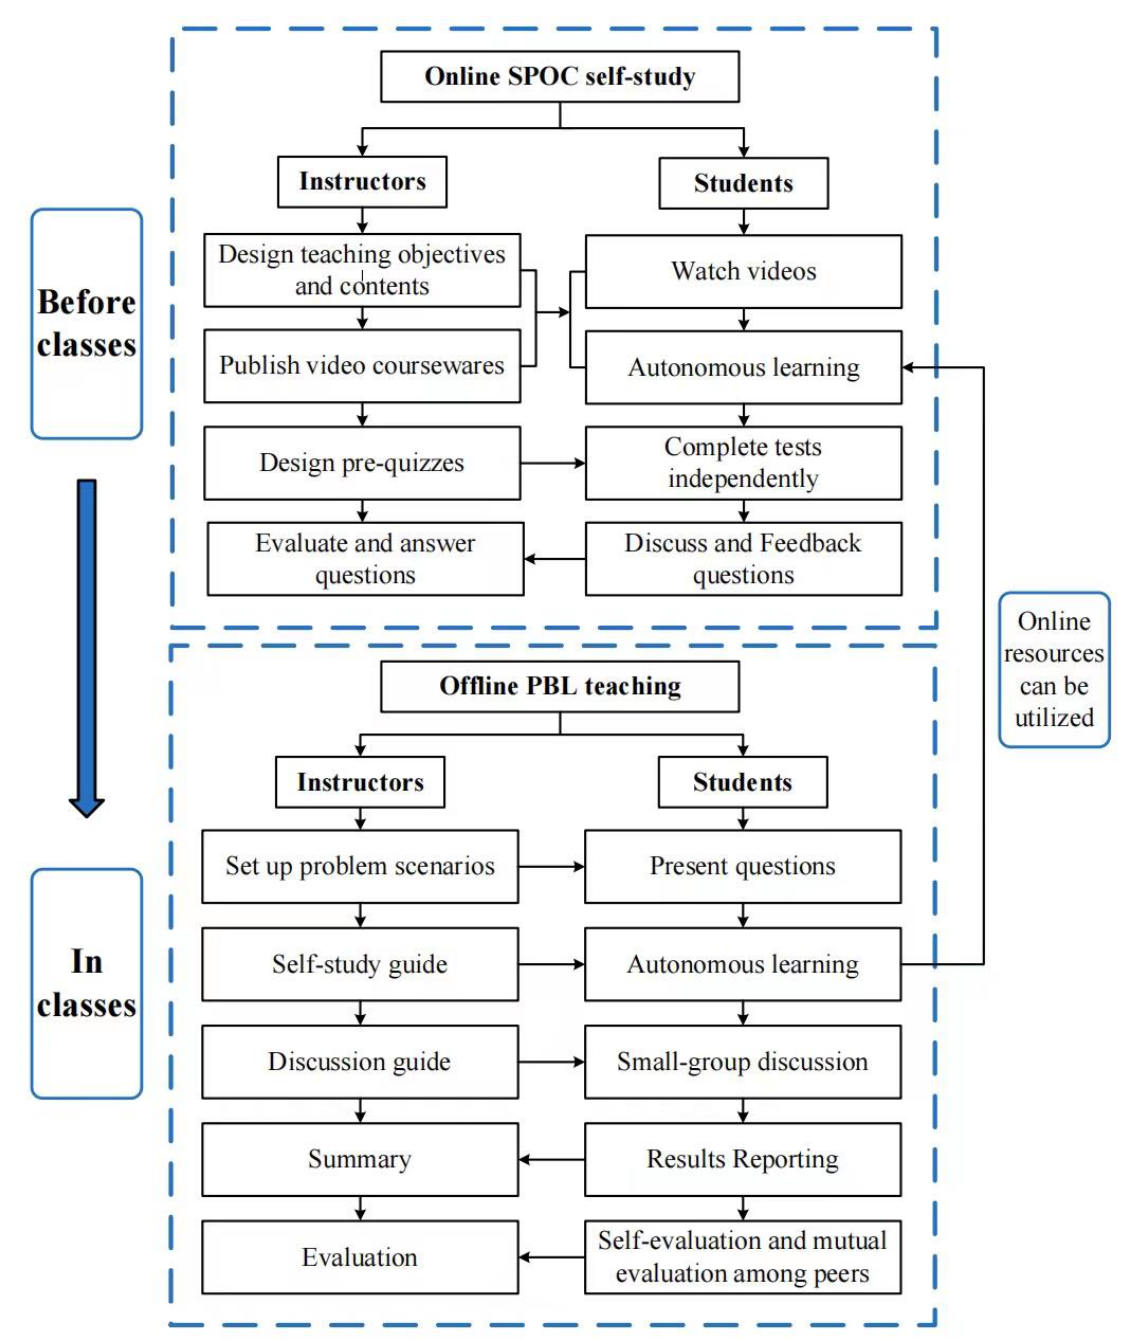
Figure 1. Schematic diagram of the online and offline flipped-classroom teaching model of SPOC combined with PBL.